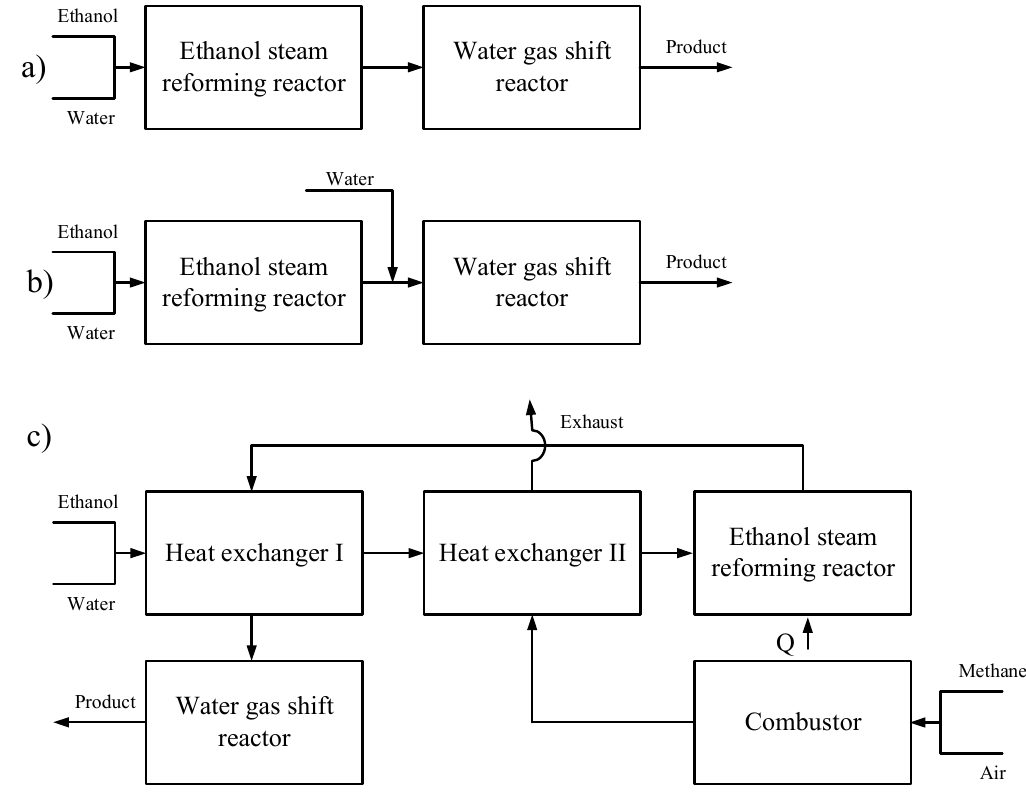
Figure 1. Different ethanol steam reformer concepts: ( a ) Typical sequential reformer and shift reactor (SRSR), ( b ) SRSR with energy management by water splitting (SRSR-WS), and ( c ) Compact heat integrated reactor systems (CHIRS).